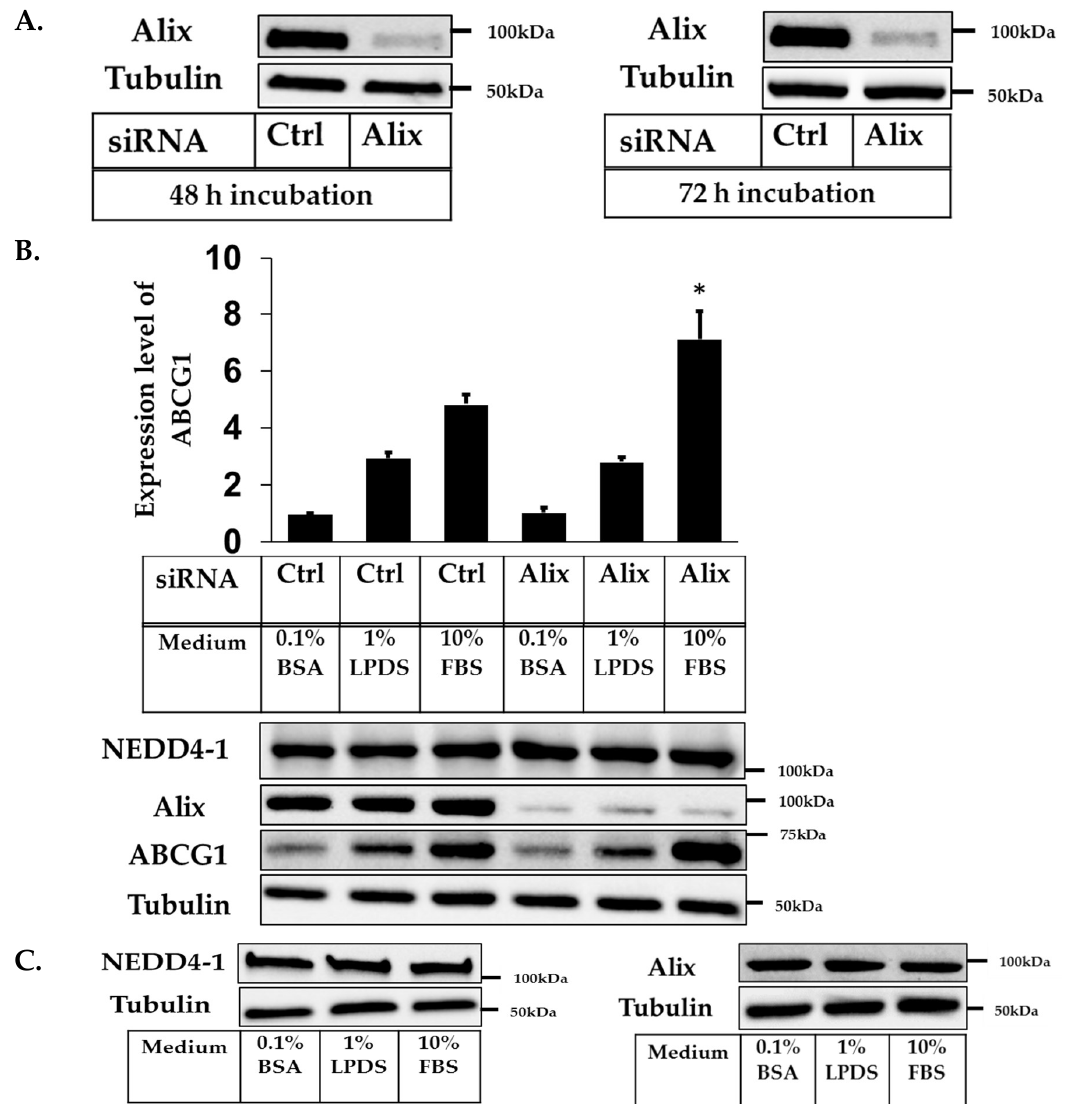
Figure 2. siRNA knockdown of Apoptosis-linked gene 2-interacting protein X (Alix) increases ABCG1 protein expression. ( A ) Immunoblots of cell lysates from ABCG1-CHOK1, transfected with either control or Alix siRNA. ( B ) Quantification of ABCG1 protein relative to tubulin (expressed as fold change relative to control 0.1% BSA) in low and normal serum conditions (mean ± SEM of seven data points from four independent experiments). * indicates p < 0.05 compared to control in 10% FBS. ( C ) Immunoblots of Alix and Neural precursor cell-expressed developmentally downregulated gene 4 (NEDD4-1) from cell lysates of ABCG1-CHOK1 in low and normal serum